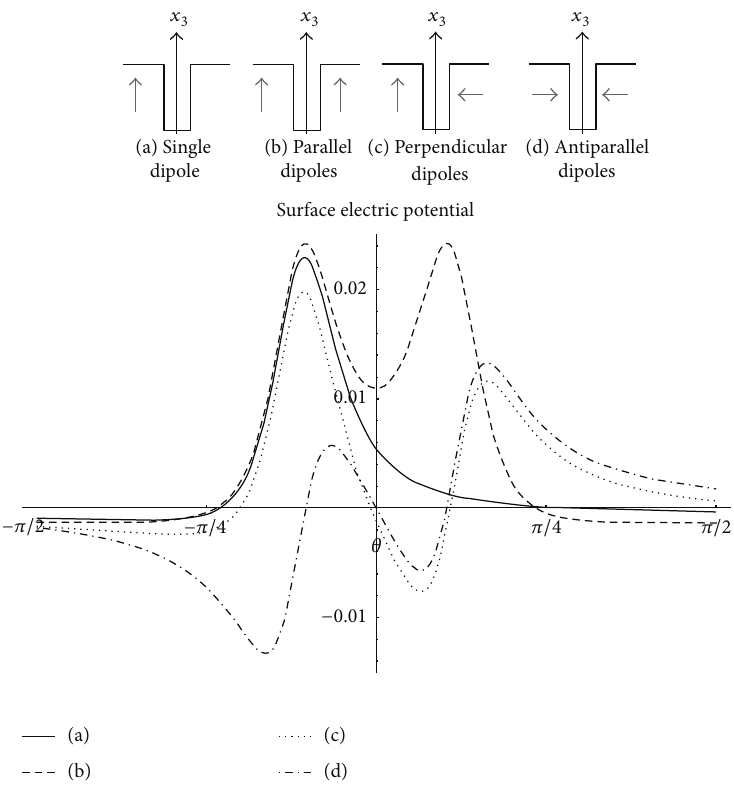
Figure 1: Electroencephalographic recordings as a result of two simultaneously active dipoles in three distinct arrangements: (b) parallel, (c) perpendicular, and (d) antiparallel. The corresponding neuronal excitation occurs on the cortical surface in neighboring regions. The presented electric potential is plotted for a fixed azimuthal angle equal to 3𝜋/8